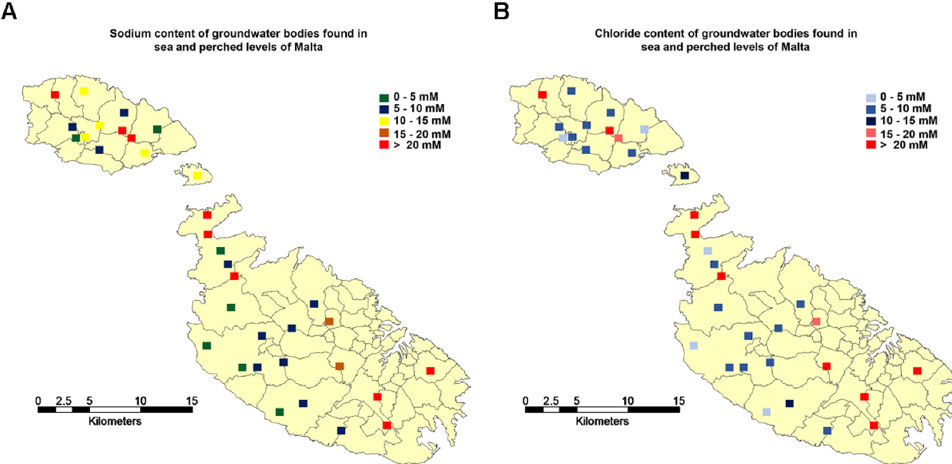
Figure 1. Concentration of sodium ( A ) and chloride ions ( B ) in groundwater in Malta. Data were taken from